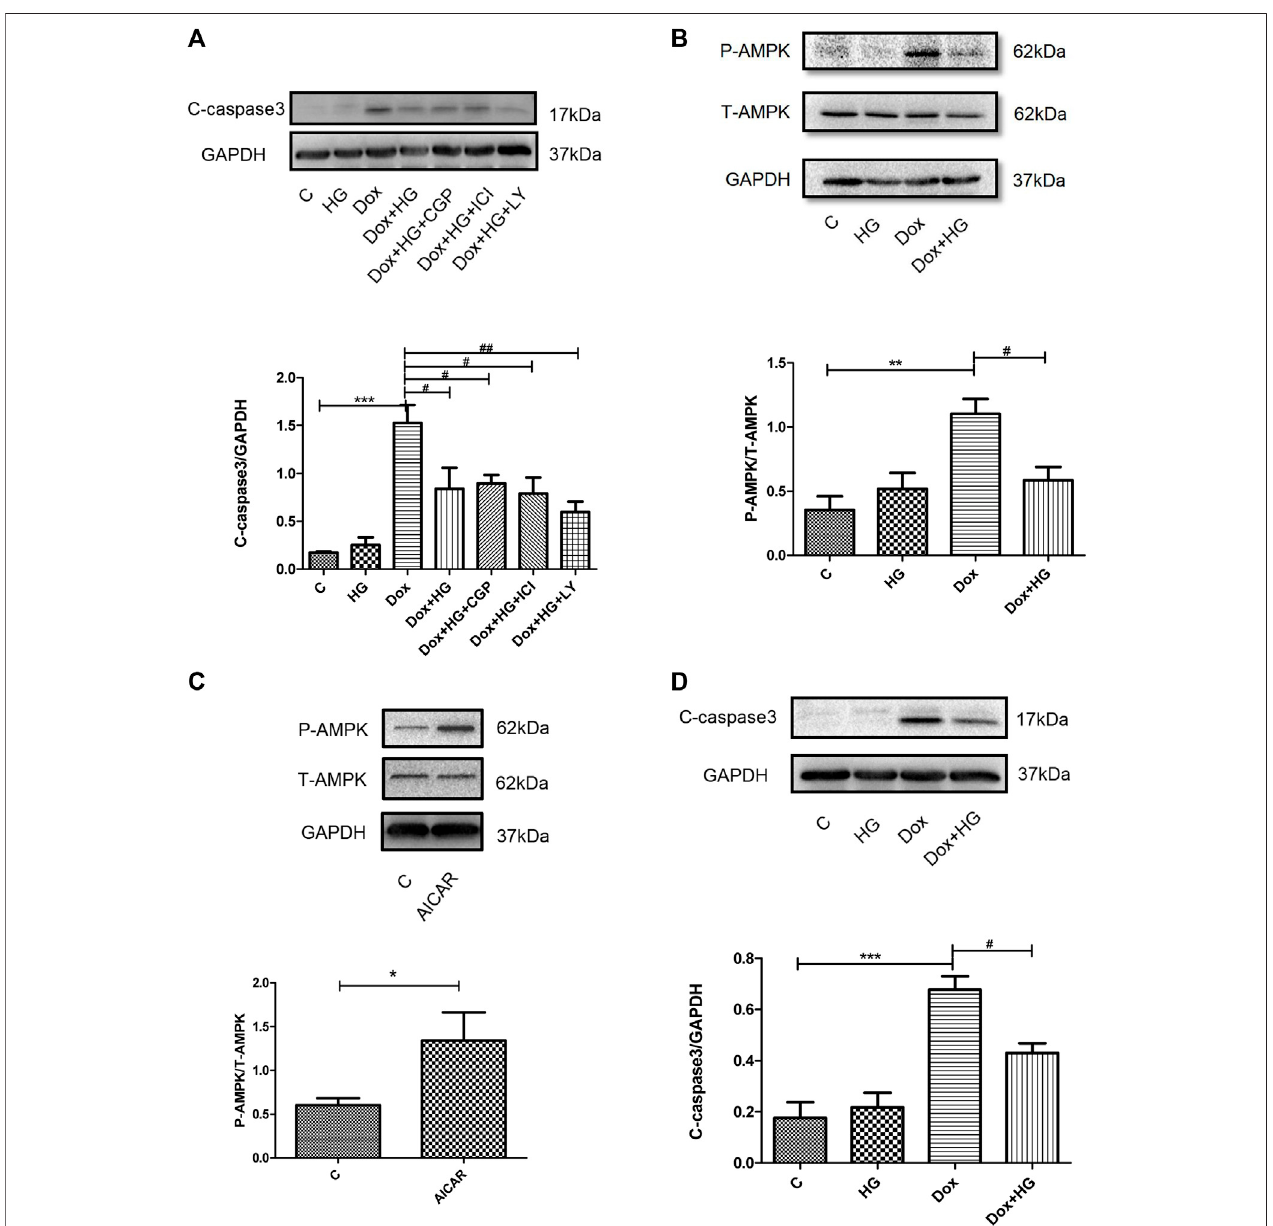
FIGURE 7A | HG blocked the AMPK signal pathway in neonatal ventricular myocytes and in mice. (A) Effect of HG was not eliminated in the presence of CGP20712a (1 μ M), ICI118551 (0.5 μ M), and LY294002 (1 μ M). (B) Western blot representative images and analysis of the expression of phosphorylated and total AMPKinneonatalventricularcardiomyocytes. (C) Westernblotrepresentativeimagescon fi rmedtheef fi cacyoftheagonistAICAR. (D) IntheabsenceofagonistAICAR, HG could inhibit DOX-induced cardiomyocyte apoptosis. (E) AICAR blocked the inhibitory effect of HG on DOX-induced cardiomyocyte apoptosis. (F) Immunohistochemical staining of the phosphorylated and total AMPK in each group of 4 weeks and the phosphorylated AMPK-positive cell for quantitative analysis in micehearts;scalebar:100 μ M.Theaforementionedexperimentswererepeatedmorethanthreetimes.Allvaluesarepresentedasmean±SEM;statisticalanalysiswas performed using Prism 8.0 one-way ANOVA. * p < 0.05 DOX vs control C, AICAR vs control C, DOX vs NS; # p < 0.05 DOX + HG vs DOX; ns, p > 0.05 DOX + HG + AICAR vs DOX + AICAR. Animal numbers: NS, n = 8; HG, n = 7; DOX, n = 10; DOX + HG, n = 10.